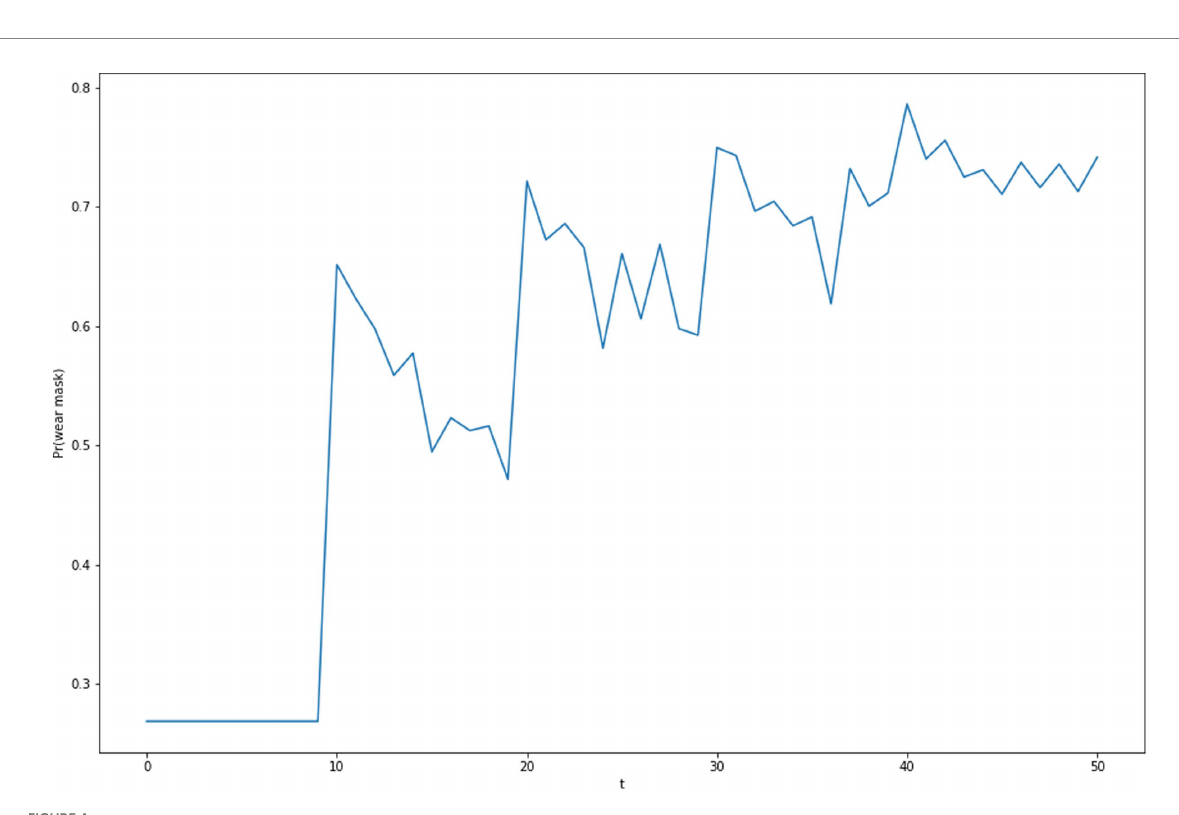
FIGURE 4 The impact of the changes of intentions in Figure 3 on mask choice